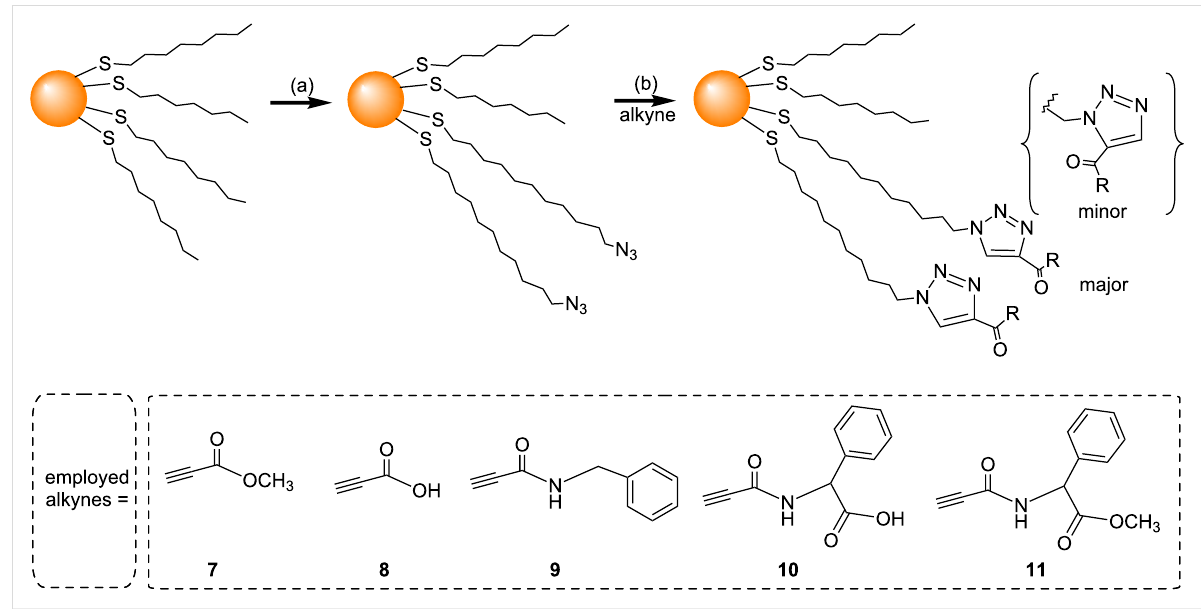
Scheme 3: Azide functionalization and NCAAC on an AuNP surface using electron deficient alkynes. Reagents and conditions: (a) HS(CH 2 ) 11 N 3 , C